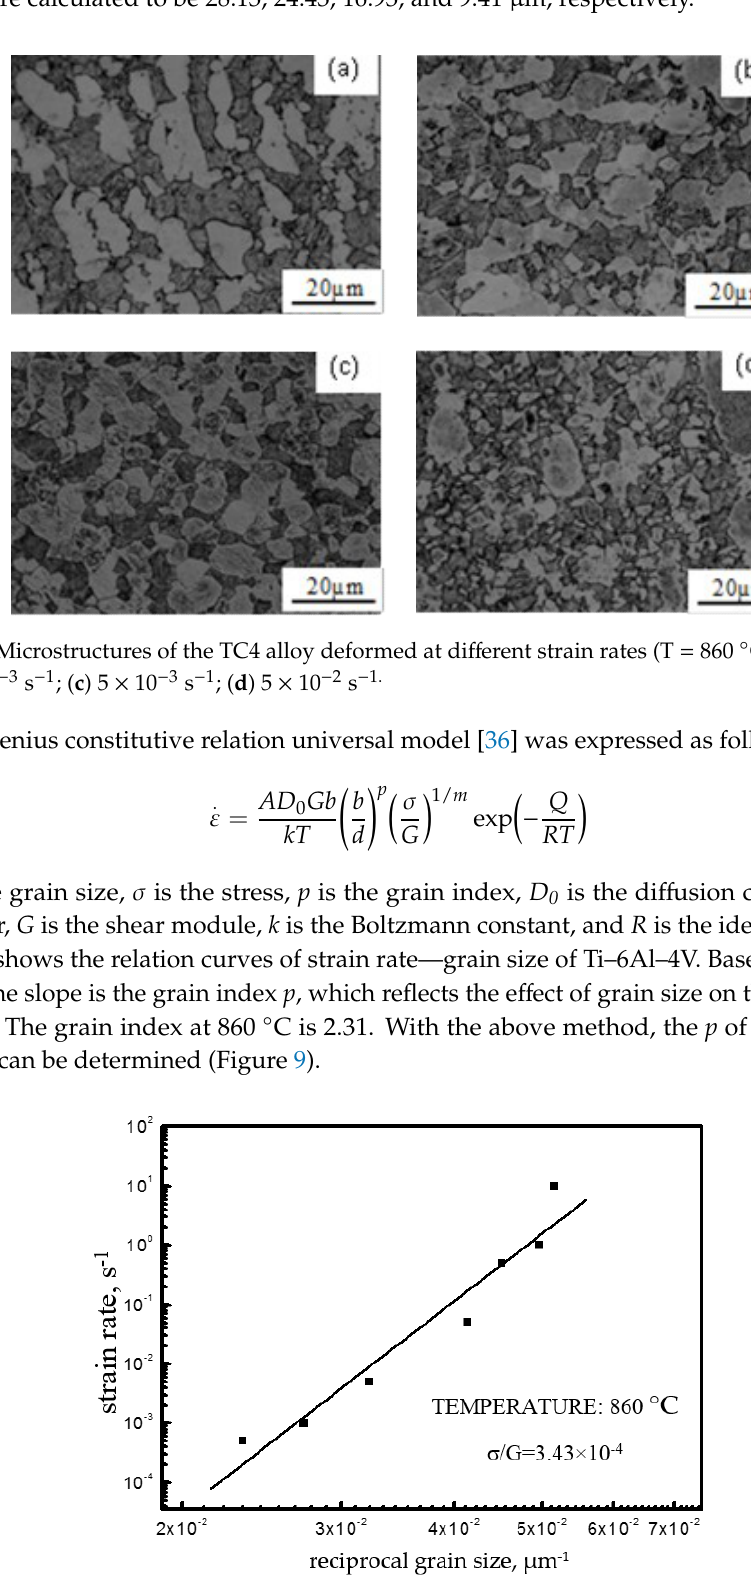
Figure 8. The variation in strain rate as a function of reciprocal grain size in Ti–6Al–4V.